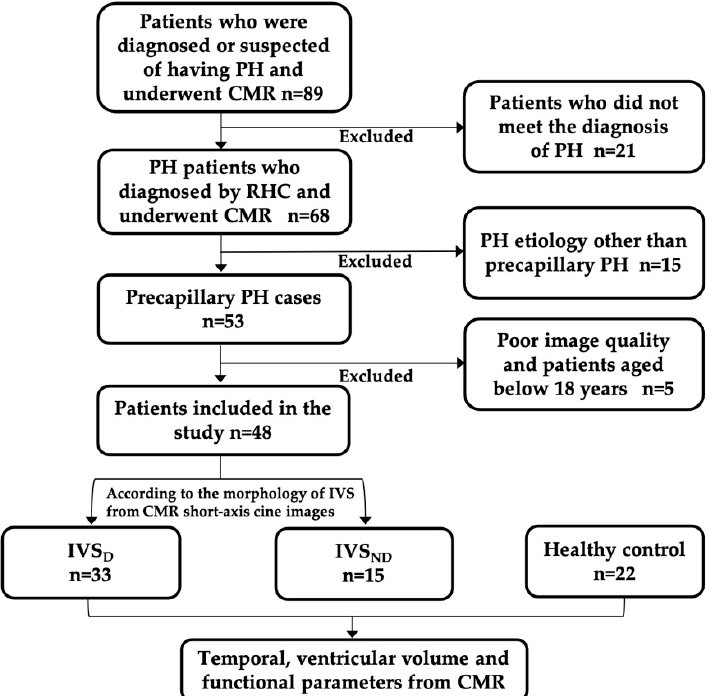
Figure 1. Patient flowchart. PH, pulmonary hypertension; CMR, cardiac magnetic resonance; RHC, right heart catheterization; IVS ND , pulmonary hypertension patients without interventricular septum displacement; IVS D , pulmonary hypertension patients with interventricular septum displacement.